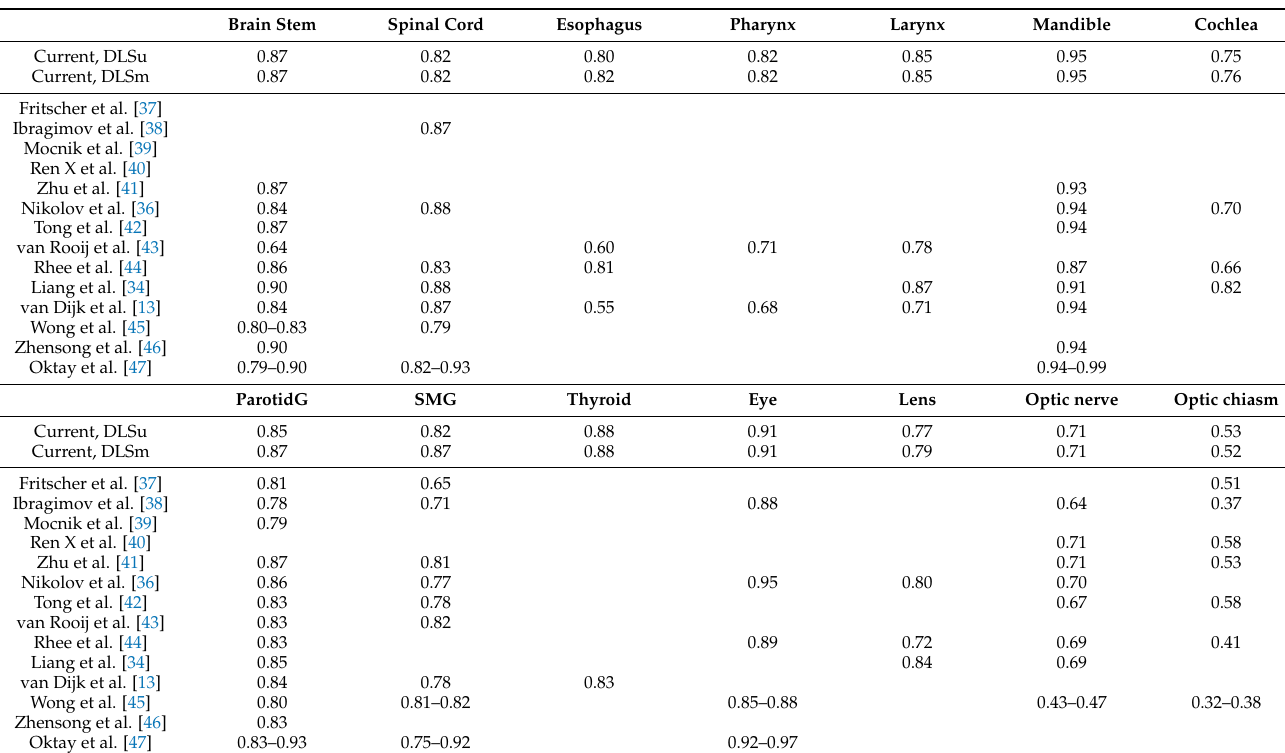
Table 3. Average volumetric Dice coefficient of our model and for previously published results. Brain Stem Spinal Cord Esophagus Pharynx Larynx Mandible